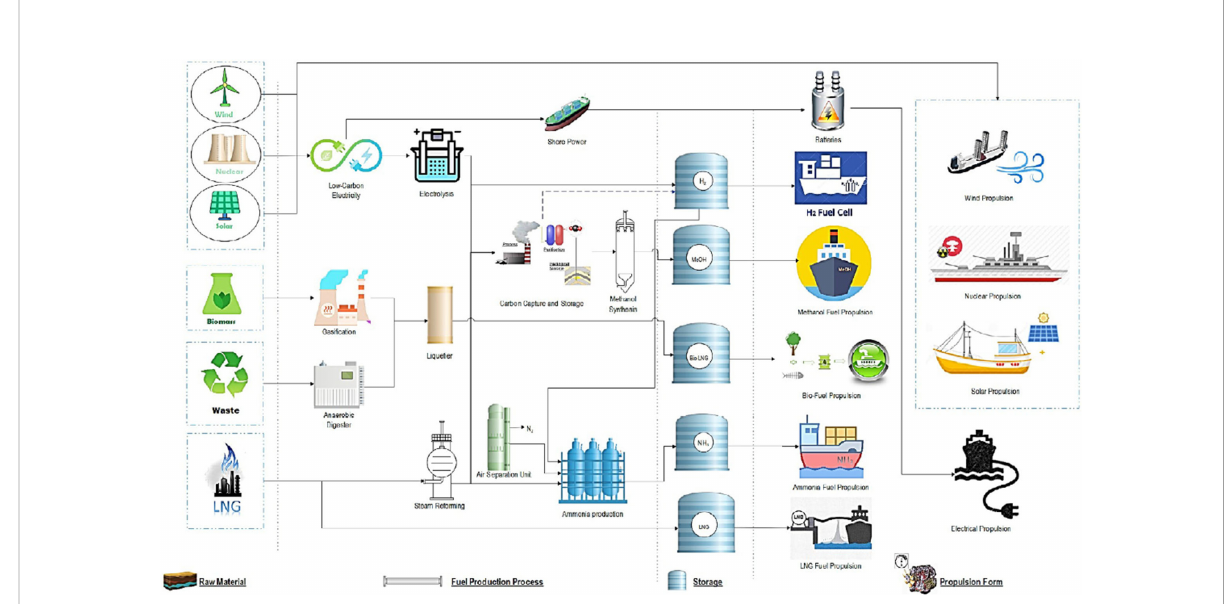
FIGURE 1 Technologies and fuels on a pathway to maritime decarbonization. Source: Department for Transport, 2019; Al-Enazi et al.,